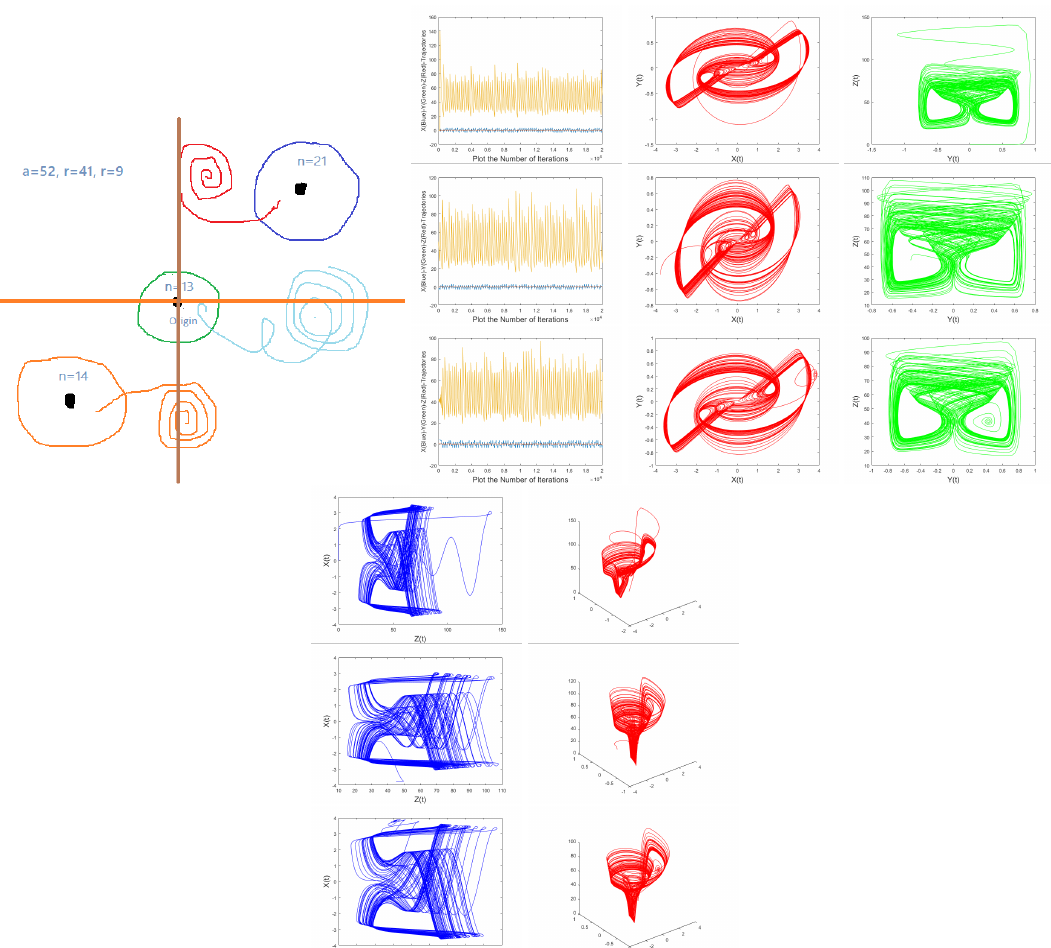
Fig. 12 Unstable trajectories which are away from the all the equilibrium points of the system D 52 , 41 , 9 [ n ] . All the parameters a = 52 , r = 41 and r = 9 keeps away the trajectories from all the three equilibrium points of the system and forming limit cycles, whereas the degree of the system is controlling the repelling behavior of those equilibrium points as